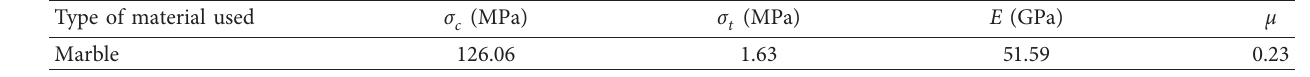
Table 1: Basic mechanical parameters of the marble used in this